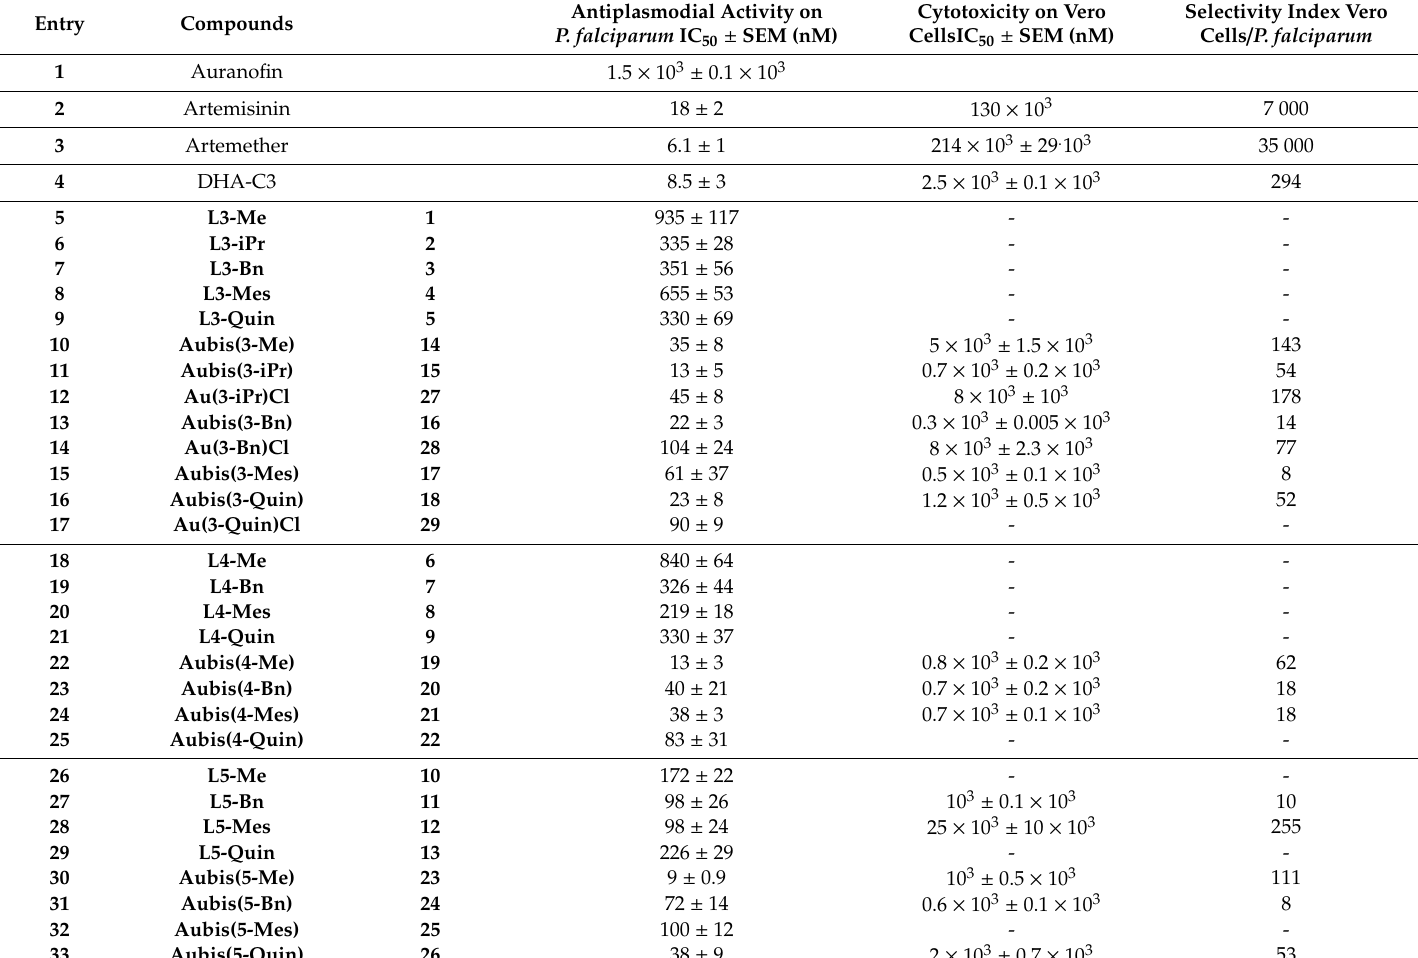
Table 1. Antimalarial and cytotoxic activities of proligands and gold(I)